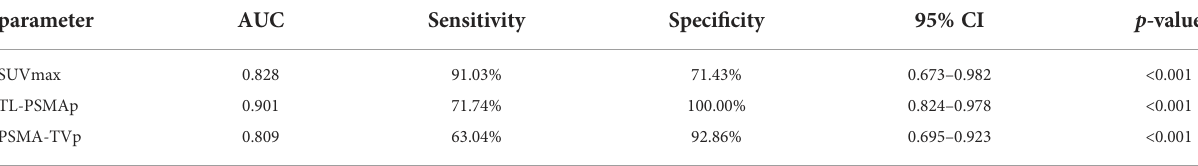
TABLE 3 AUC characteristics for the investigated semi-quantitative PSMA-PET parameters.